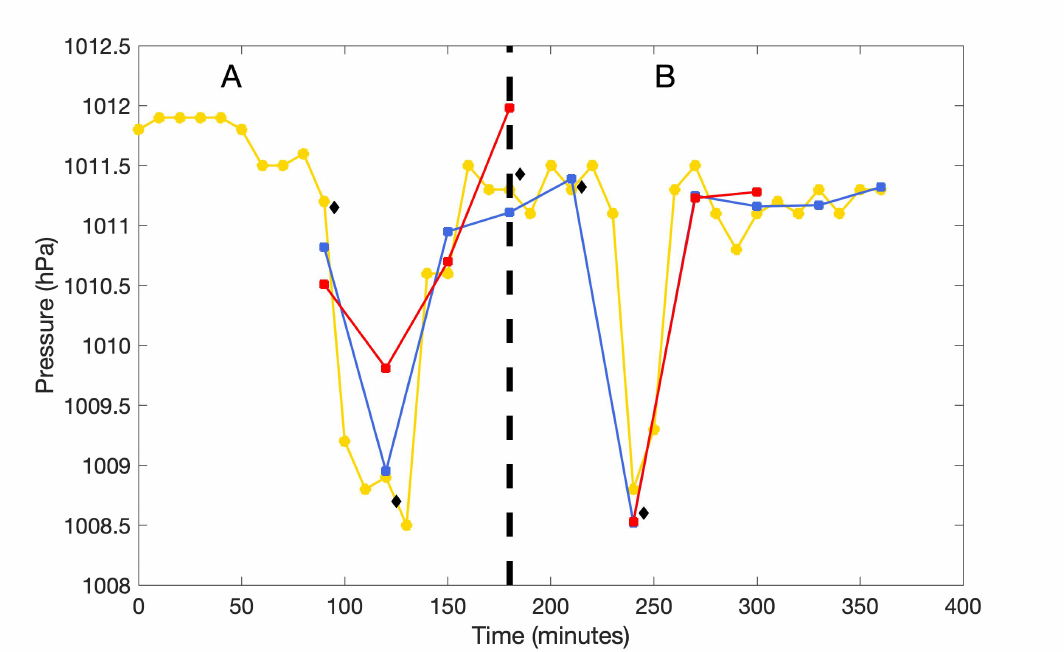
Figure 7. Comparison of pressure data measured by the BaroDiver (yellow), DPI 740 (black diamonds), and the GLOF buoys A and B (red and blue, respectively). The thick dashed line separates the initial test without the extra vent installed (A) and testing after extra vent was installed